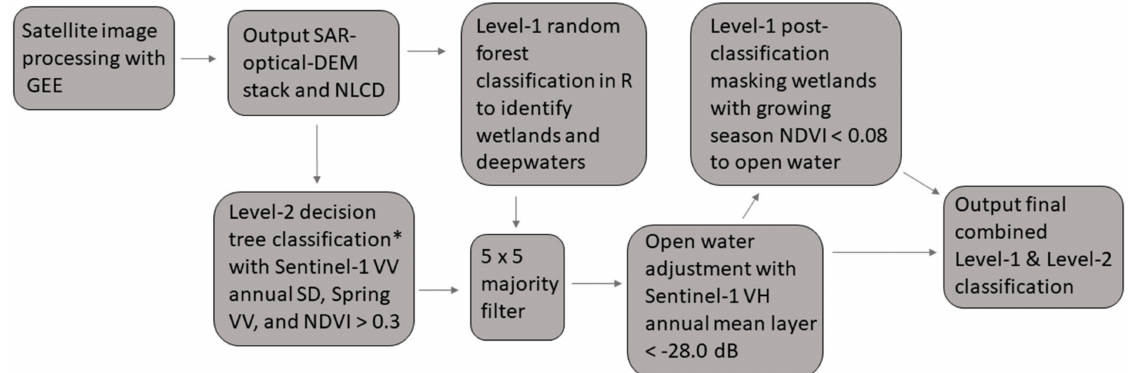
Figure 4. Schematic of image processing, classification, and post-classification adjustments. * Level-2 decision tree classification final derivation is depicted in the following section (Figure 5).